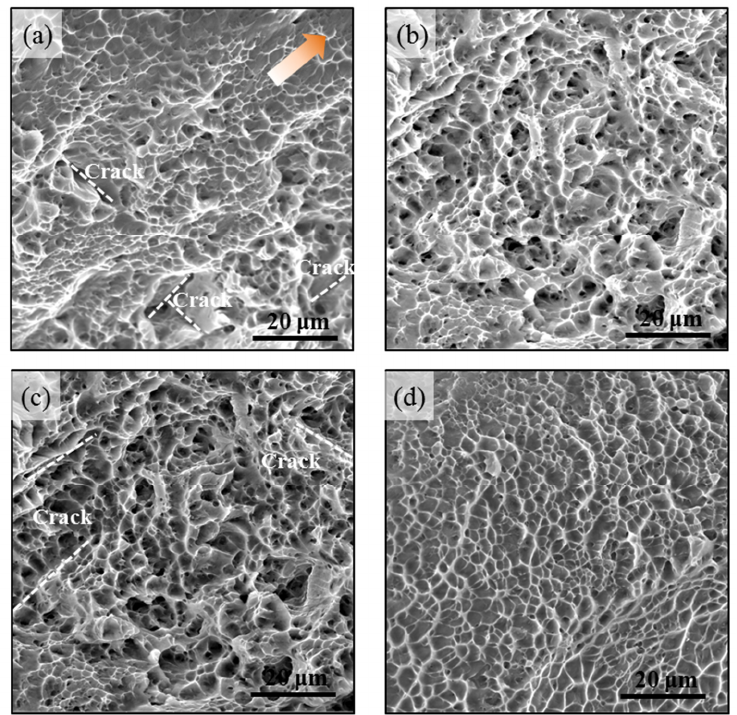
Figure 9. Fractography of α s + β and α p , s + β Ti alloy at quasi-static and dynamic loading conditions. The α s + β Ti alloy under ( a ) quasi-static loading and ( b ) dynamic loading. The α p , s + β Ti alloy under ( c ) quasi-static loading and ( d ) dynamic loading. The arrow represents the shear direction.